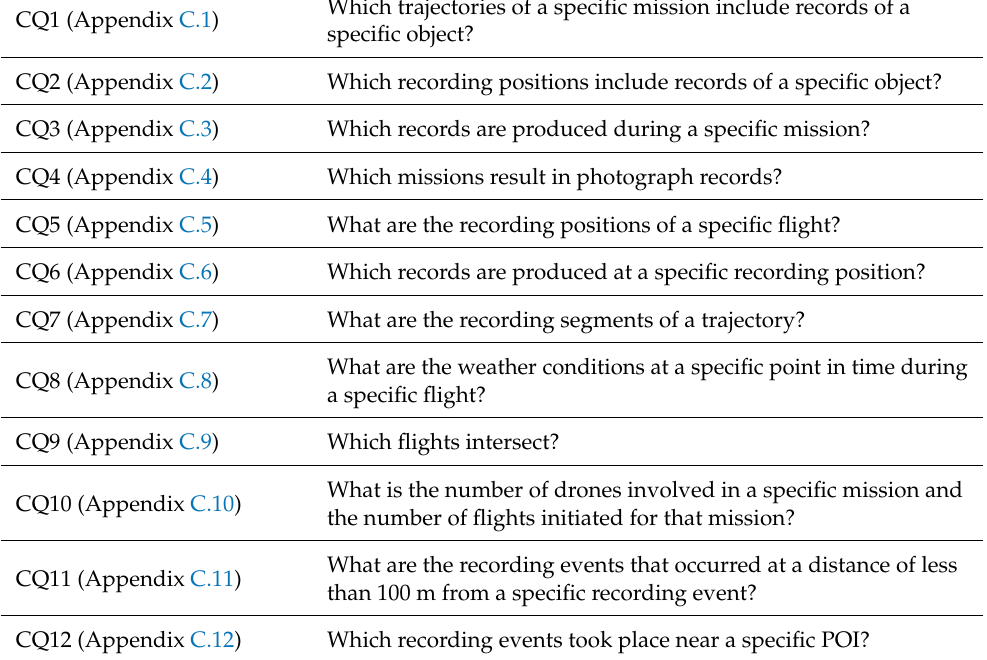
Table 6. Competency questions answered by the implemented